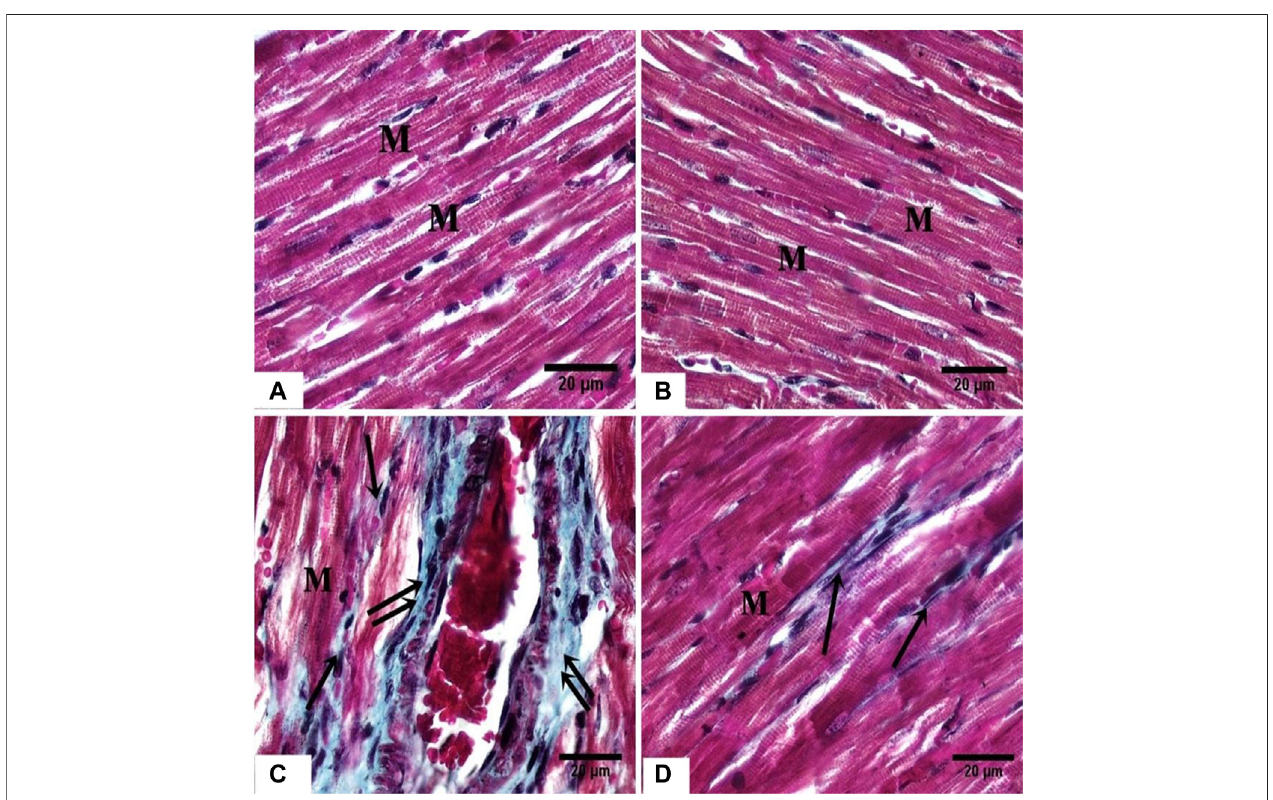
FIGURE 4 | photomicrographs of sections in the rat myocardium (A, B) From group (I) and group (II) respectively show the cardiac fi bers (M). (C) From group III, showing marked deposition of collagen fi bers (arrow) between the cardiac fi bers (M) and around the blood vessels (double arrow). (D) From group (IV) showing mild deposition of collagen fi bers (arrow) between the cardiac fi bers